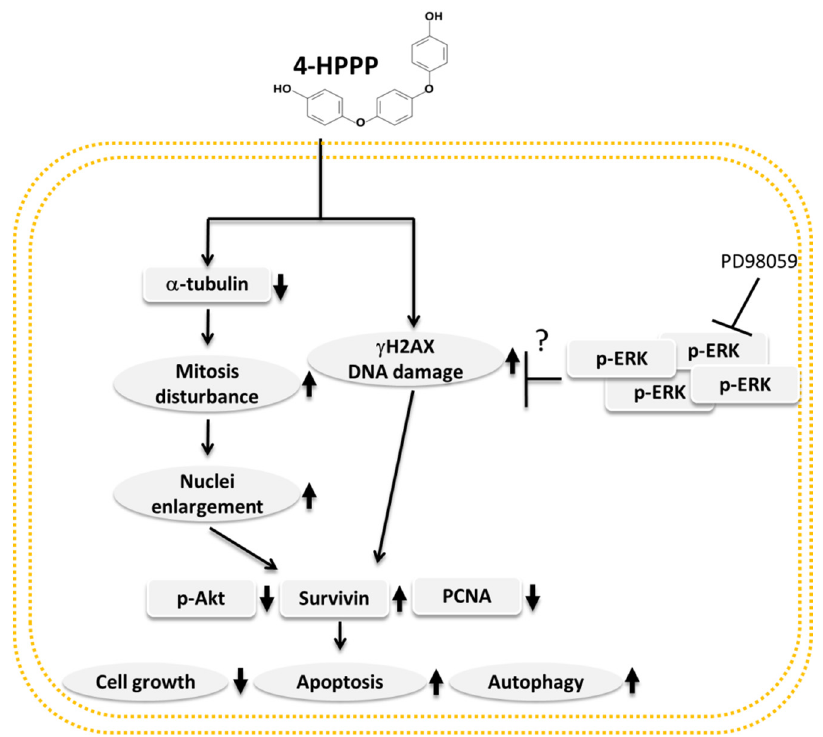
Figure 10. Proposed mechanism of 4-HPPP-induced apoptosis, autophagy and reduced expression of α -tubulin in HCC cells.